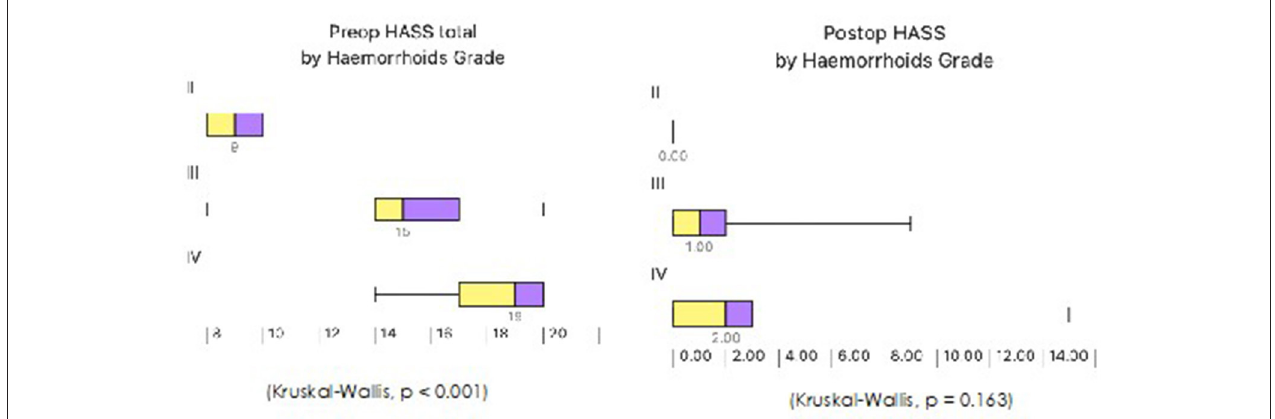
FIGURE 4 | Correlation between hemorrhoids grade and HASS.